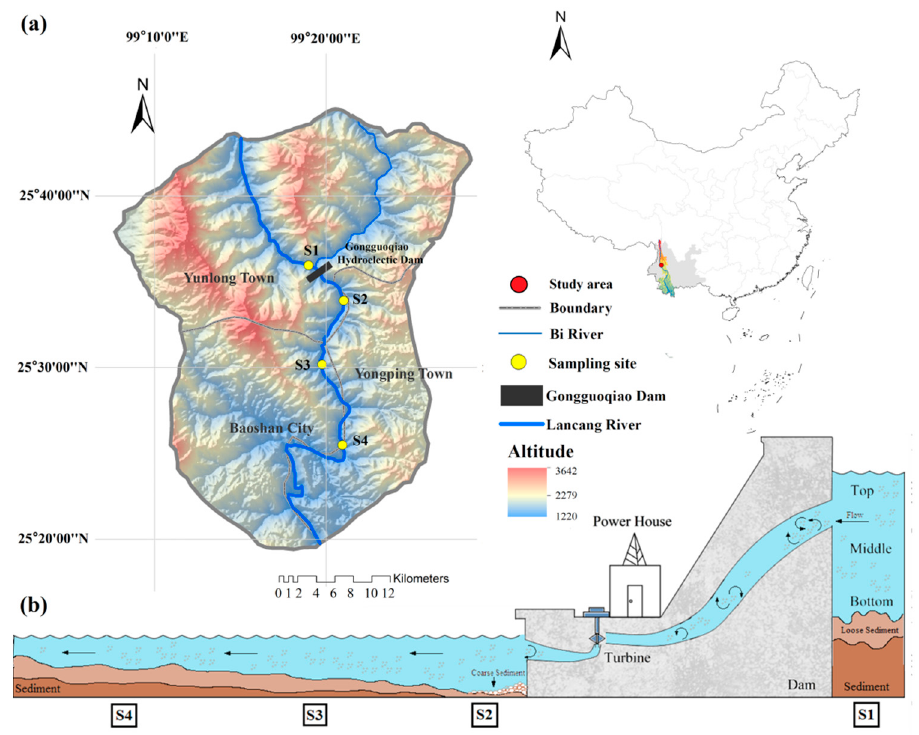
Figure 1. Map of the sampling locations. ( a ) Location of sampling sites in the upstream and downstream of Gongguoqiao hydroelectric dam in the Lancang River Basin, Yunnan Province, China. ( b ) Schematic showing the dam and four sampling stations.